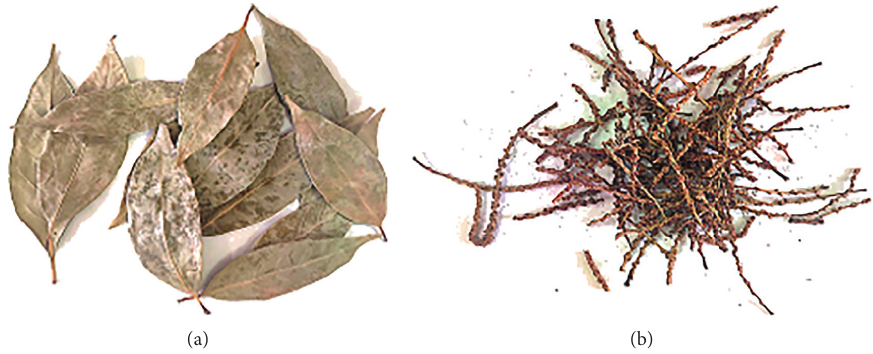
Figure 1: LP sample diagram: (a) LP sample diagram of tender leaves; (b) LP sample diagram of flower